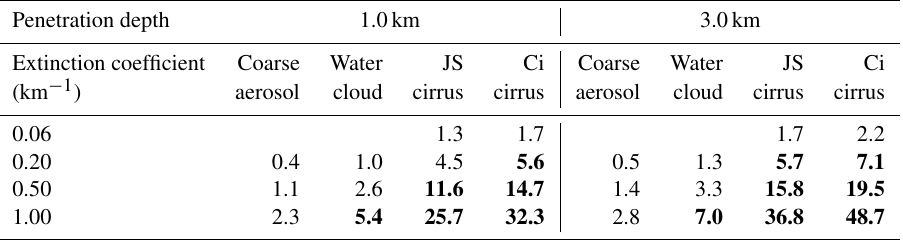
Table 3. Multiple-scattering contribution to lidar signals in per cent (%) of the single scattering. The distance to the cloud base is 8km; the lidar RFOV is 0.25mrad. Values exceeding 5% threshold are in bold